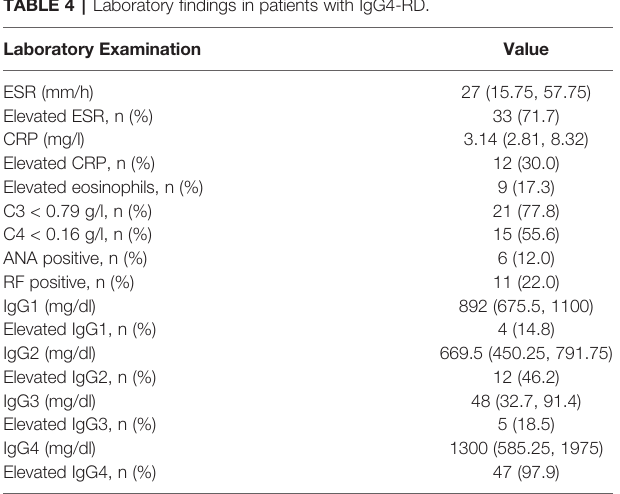
TABLE 4 | Laboratory fi ndings in patients with IgG4-RD. Laboratory Examination